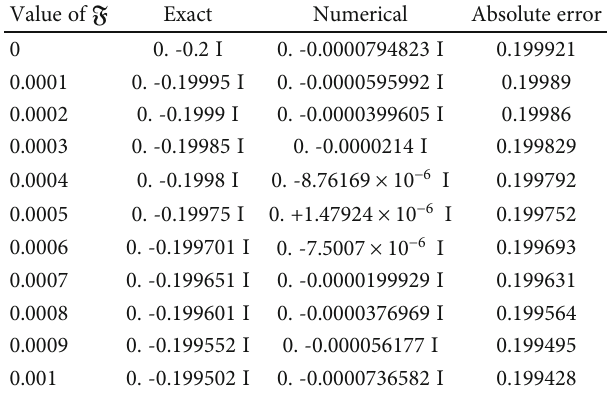
Table 2: Exact and numerical value of the Atangana conformable derivative ( 1 + 3 )-ZK equation with power-law nonlinearity through the obtained analytical solutions via the modi fi ed Khater method Equation (19) and septic B-spline scheme.